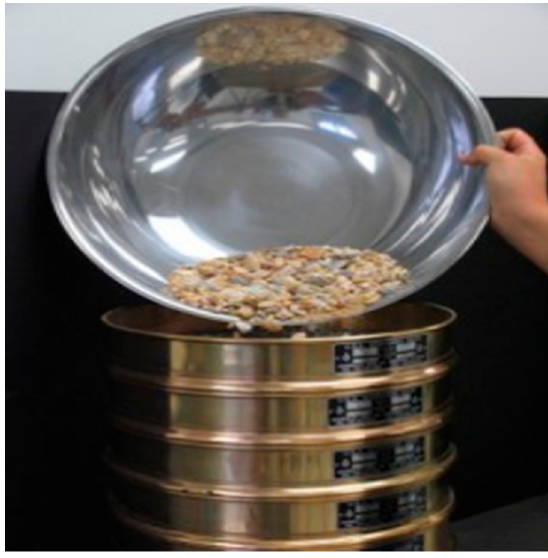
Figure 3. A representation of the immersion set-up.